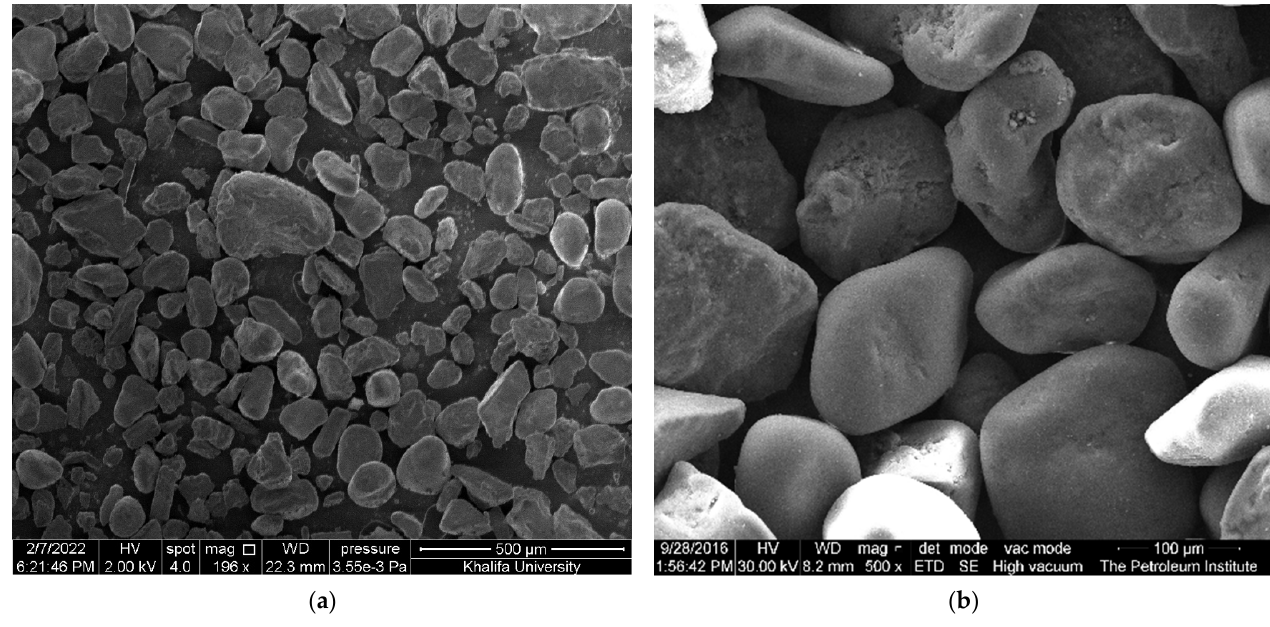
Figure 2. SEM image of silica sand: ( a ) un-sieved and; ( b ) sieved (125–250 µm).